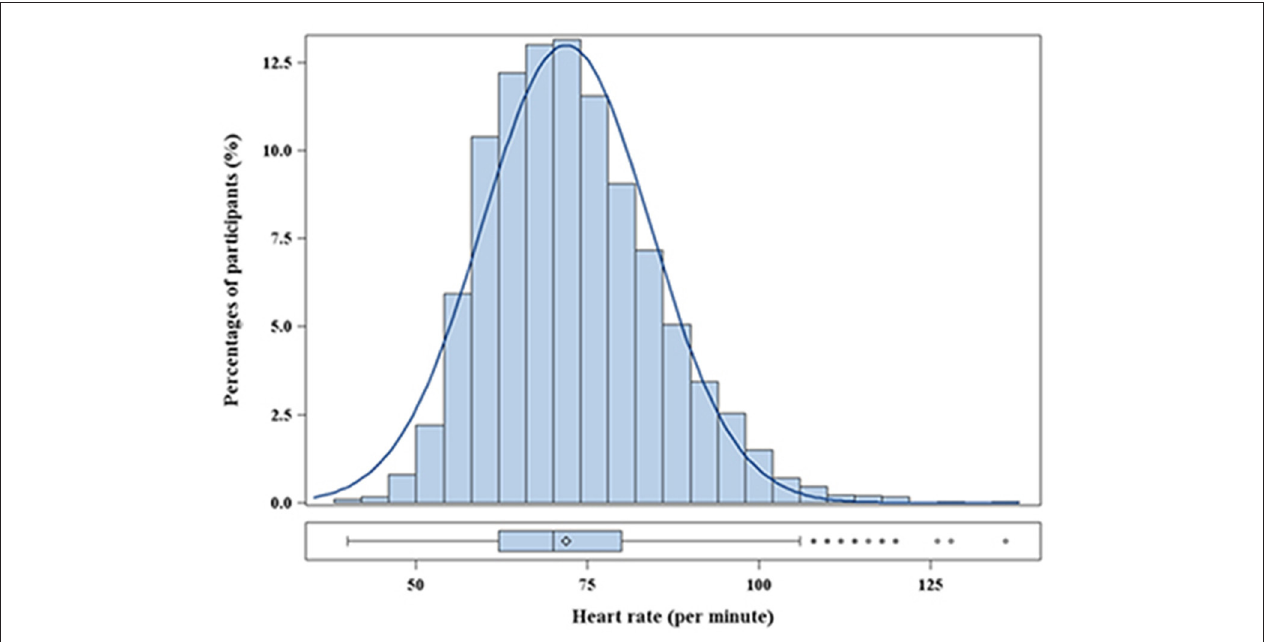
FIGURE 1 | Distribution of heart rate in